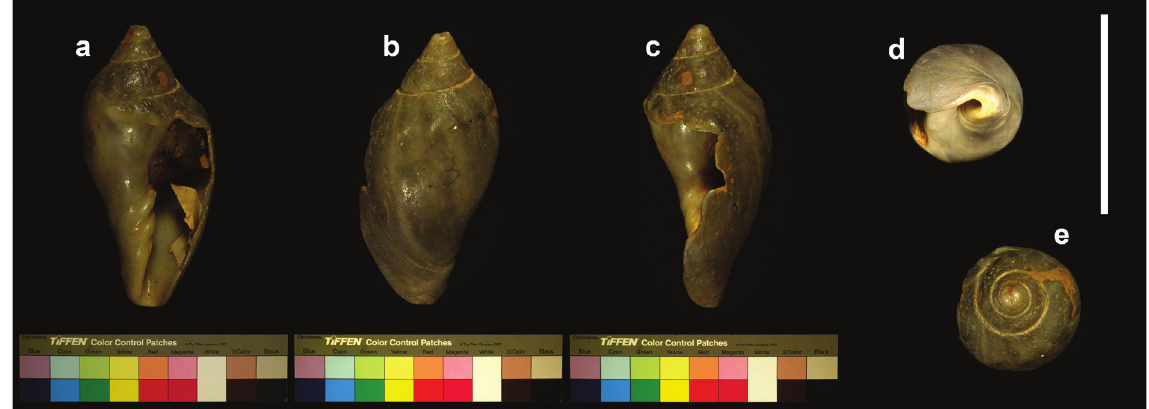
Figure 55. Voluta tuberculata ambigua , specimen figured by Lahille (1895: pl. VIII, fig. 155). a Apertural view b Dorsal view c Lateral view d Umbilical view e Apical view. Scale bar: 5